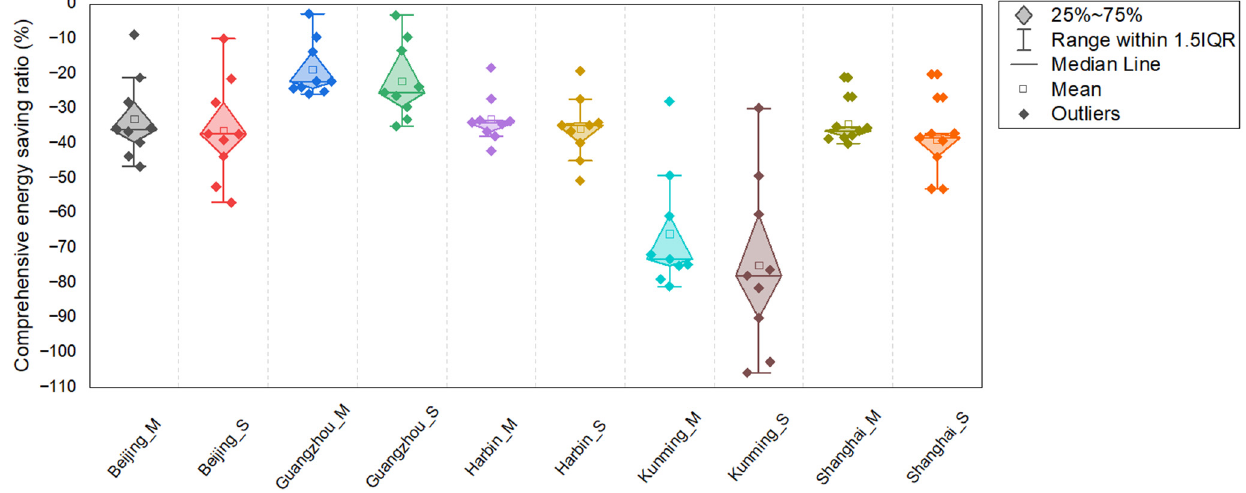
Figure 19. Comprehensive energy-saving potential comparison of typical cities in different climate zones.